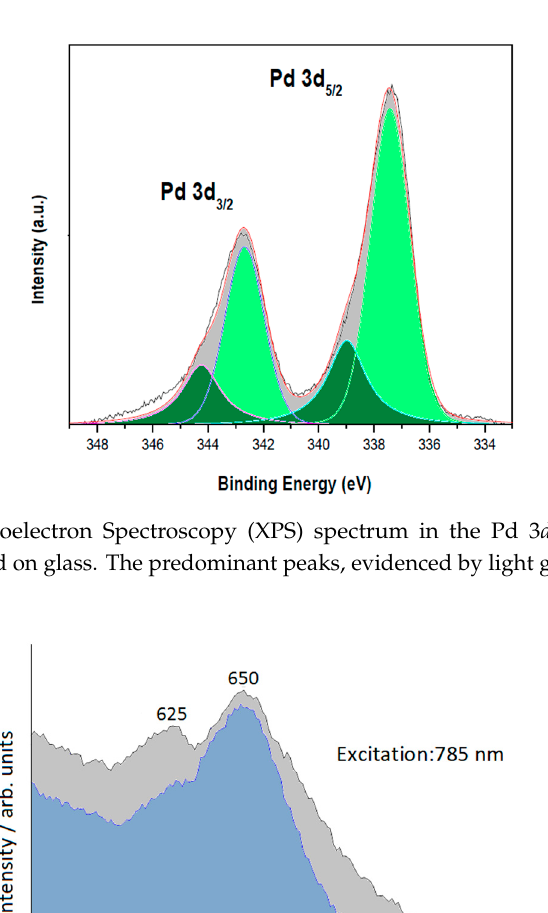
Figure 3. X-ray diffraction (XRD) of the centrifuged colloidal suspension, after drying on a silicon substrate. Reference diffraction patterns of palladium(II) oxide (PdO) (blue segments) and palladium(II) nitrate (Pd(NO 3 ) 2 ) (red segments) correspond to the Power Diffraction Files (PDF)s of palladium oxide and palladium nitrate, respectively.